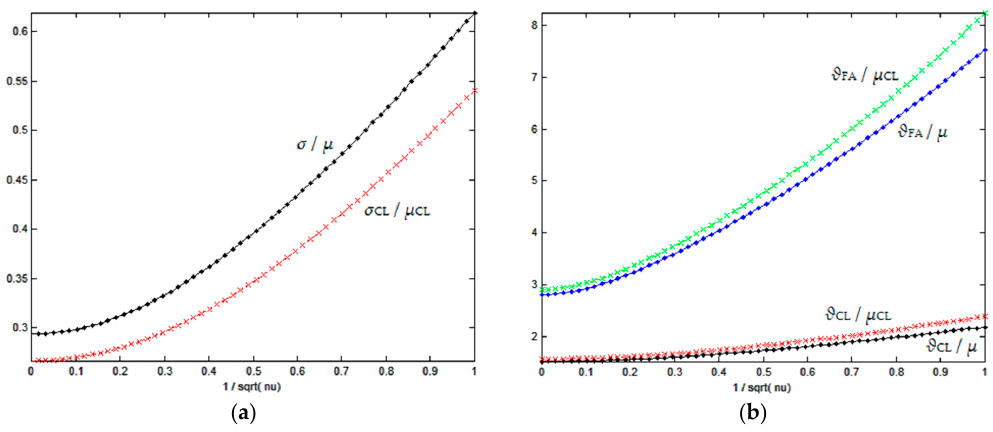
√ ν . ( a ) σ / µ ( black /upper) and